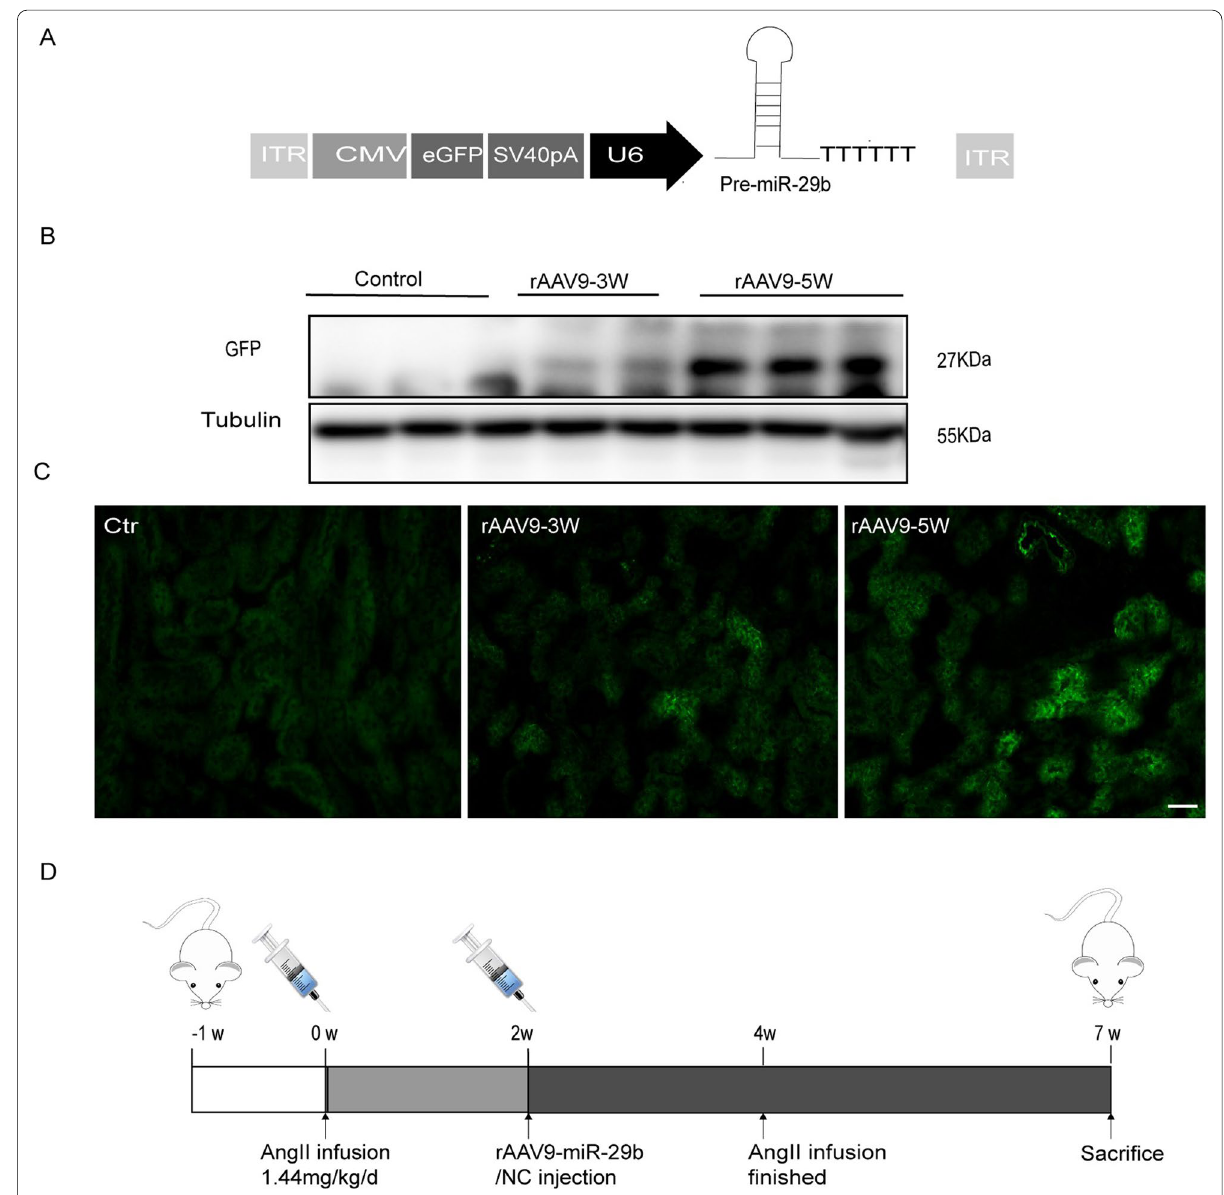
Fig. 1 Design of the rAAV9 mediated miR‑29b transduction in vivo. A Schematic representation of miR‑29b expression cassette. The expression cassette was comprised of miR‑29b stem‑loop sequence flanked by its native intron sequence, which preserves the putative hairpin structure and proper endogenous processing. A genomic fragment 800 bp containing the miR‑29b precursor was PCR amplified from the mouse miR‑29b precursor sequence and cloned into the self‑complementary rAAV9. miR‑29b under the control of cytomegalovirus and U6 promoter. rAAV9‑GFP transduction in renal tissue was tested by GFP B western blot and C fluorescence in fresh frozen sections of kidney. In AAV‑injected kidneys, there is significant EGFP fluorescence in tubule epithelial cells at 5 weeks. D Overall design of the study in vivo. Mouse were subjected to continuous AngII or PBS infusion. Two weeks later, when fibrosis was evident, the animals were randomly chosen to receive either recombinant adeno‑associated vector type 9 carrying miR‑29b (rAAV9‑miR‑29b) or control vector (rAAV9‑random miR) at 5*10 10 IVP per kidney via in situ